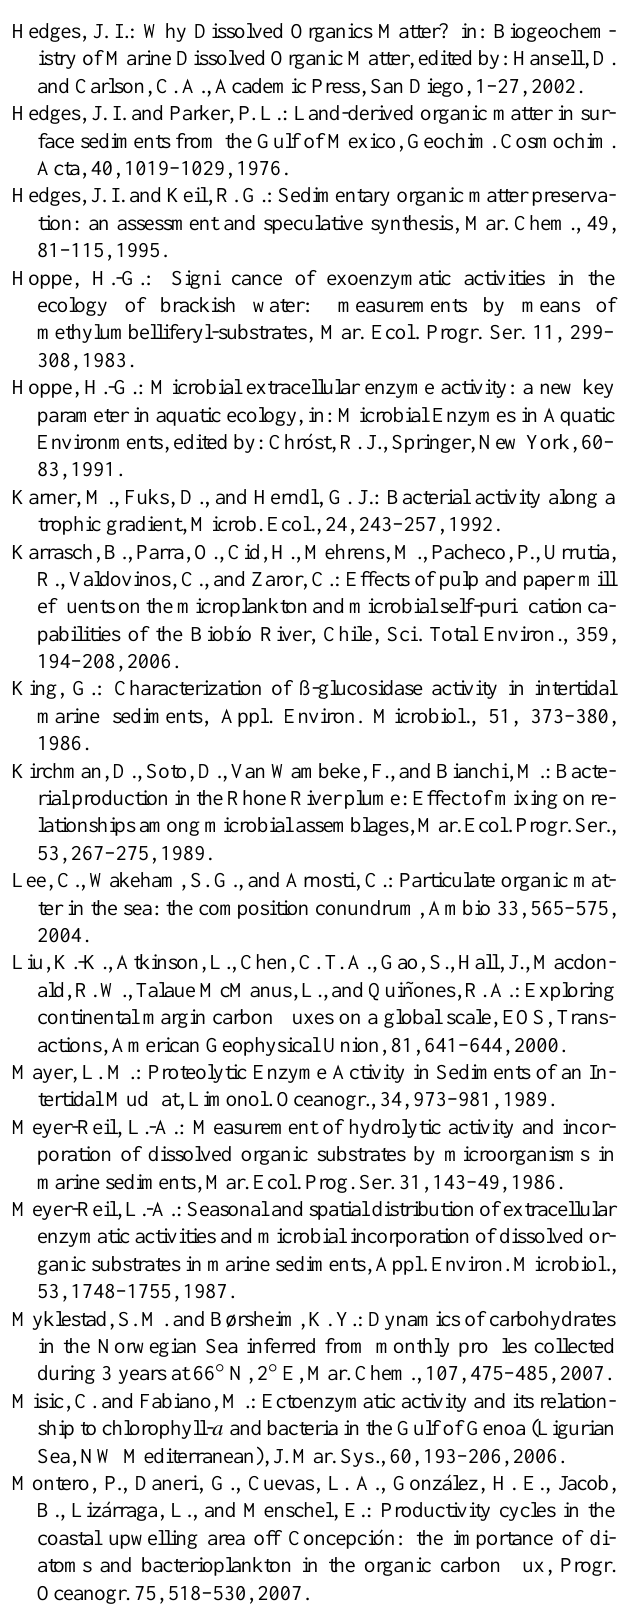
Figueroa, D. and Moffat, C.: On the influence of topography in the induction of coastal upwelling along the Chilean coast,